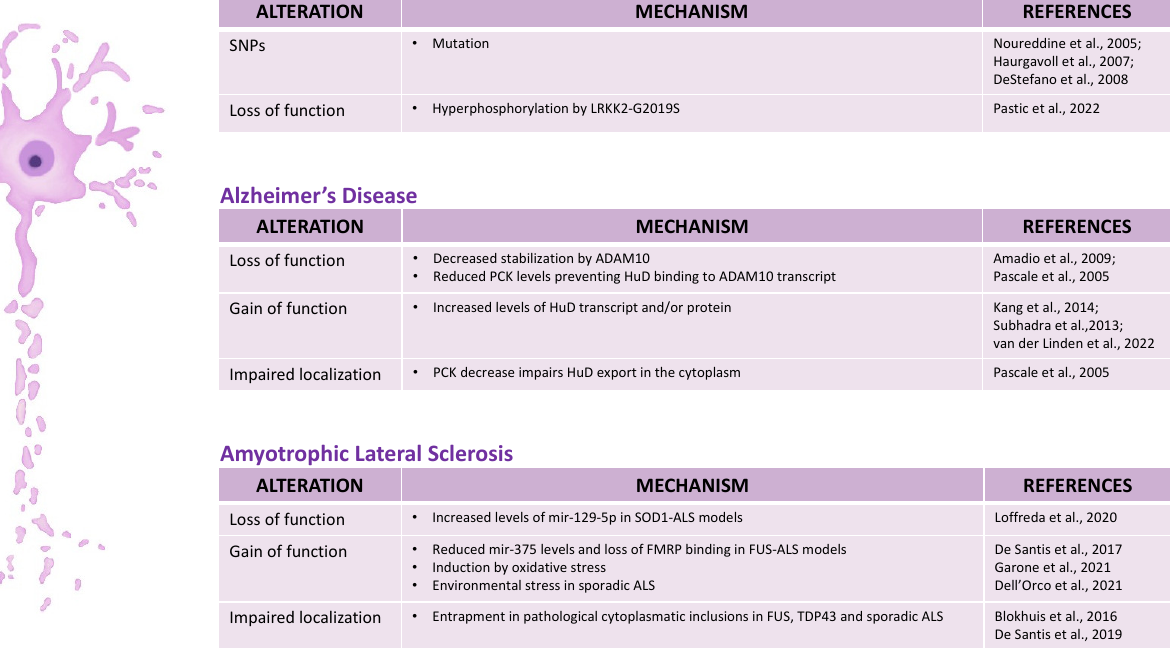
Figure 3. Summative figure of the evidence on the possible implication of HuD in major neuro- degenerative diseases [25,26,28,44,46–56].